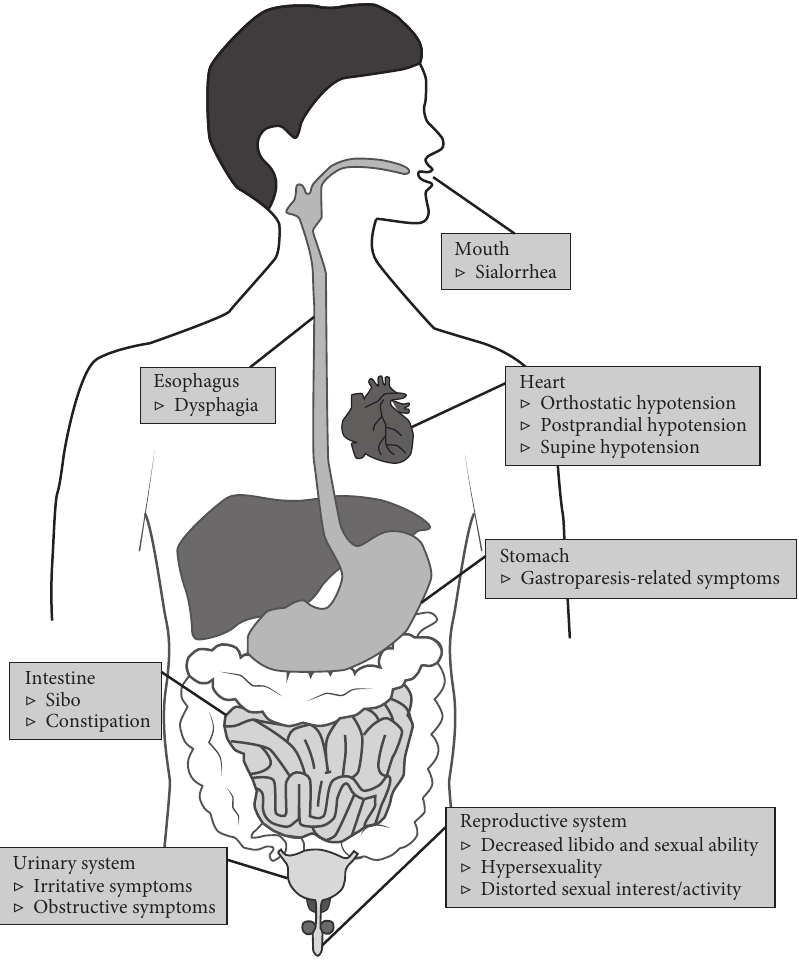
Figure 1: Clinical manifestations of autonomic dysfunctions in PD. SIBO: small intestine bacterial